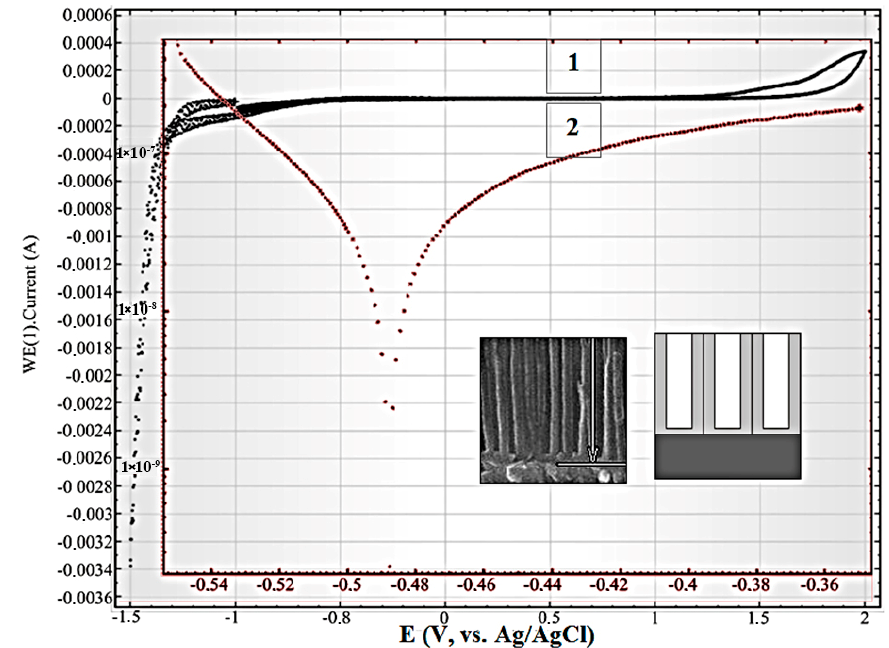
Figure 4. Cyclic (1) and linear sweep (2) voltammograms of the Si/SiO 2 /Ti sample in the 0.9% aqueous solution of NaCl at a potential scanning rate of 0.1 V/s.